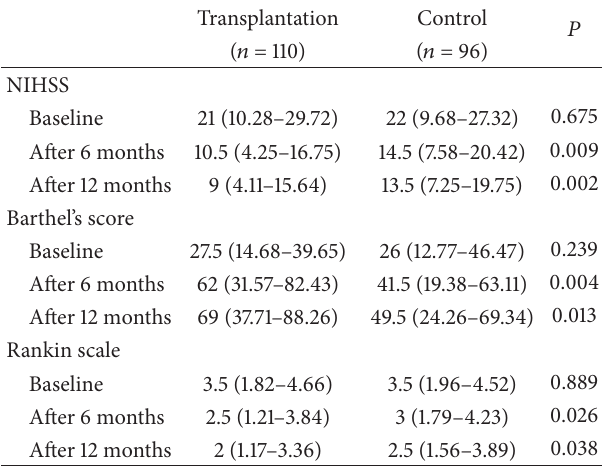
Table 5: NIHSS, Barthel’s scores, and Rankin scale for transplant and control groups before surgery and 6 and 12 months after surgery.